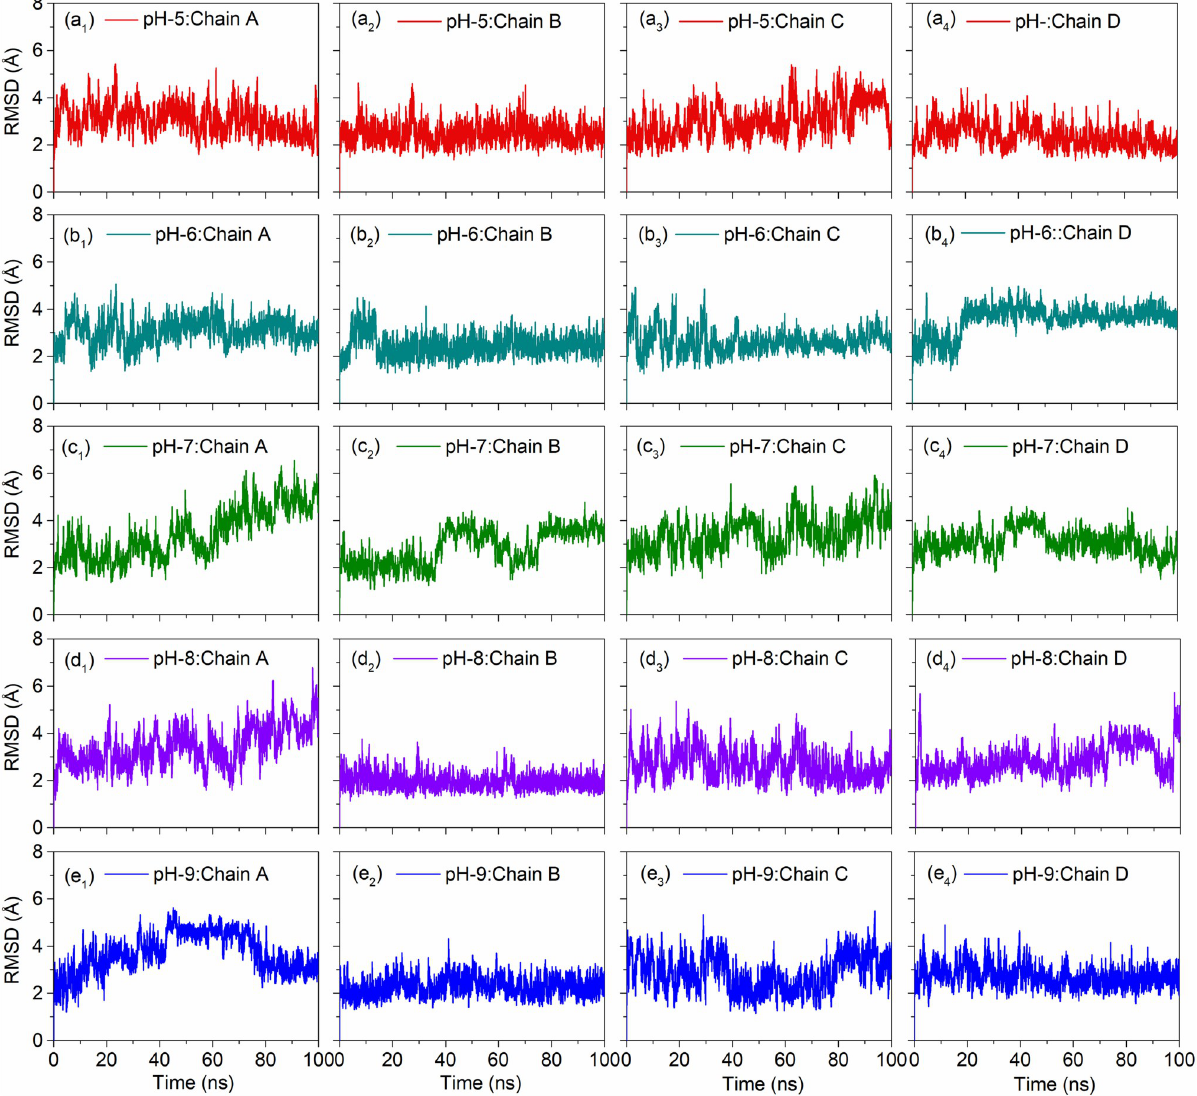
Fig 7. RMSD plots of the MD simulations of the DNA junction under 300K with altered pH, viz. (a 1 -a 4 ) pH5, (b 1 -b 4 ) pH6, (c 1 -c 4 ) pH7 as reference, (d 1 -d 4 ) pH8, and (e 1 -e 4 )